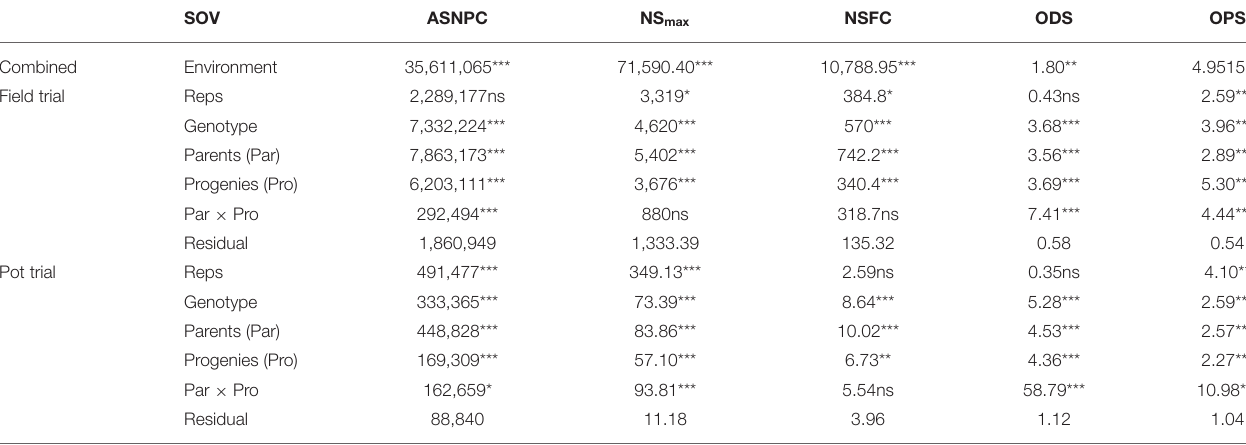
TABLE 3 | Mean squares of Striga- , disease-, and pest-related traits measured under field trial and pot trial. SOV ASNPC NS max NSFC OPS Combined